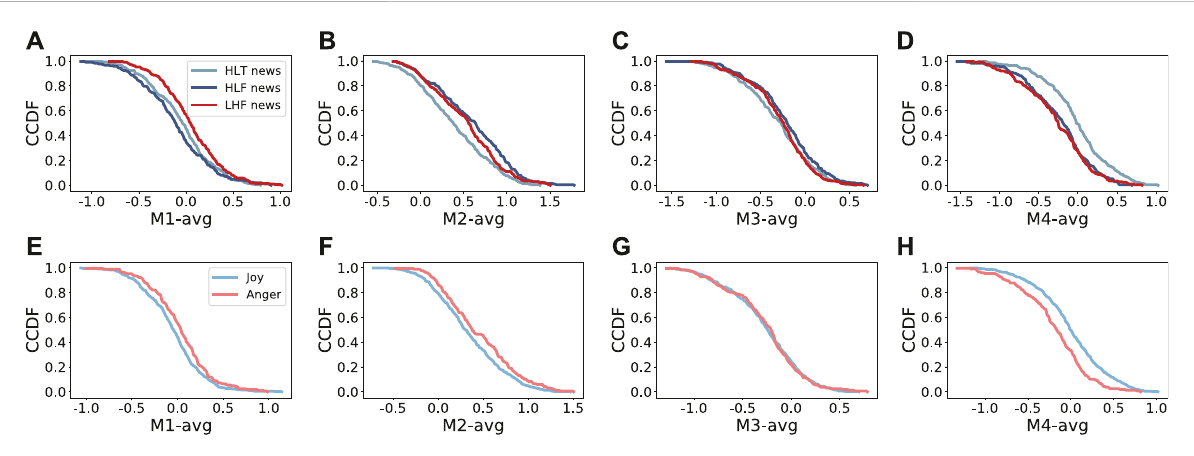
FIGURE 5 TheCCDFsofretweetingmotivations. (A,E) Anxietymanagement(M1-avg). (B,F) Informationsharing(M2-avg). (C,G) Relationshipmanagement (M3-avg). (D,H) Self-enhancement (M4-avg). (A – D) The CCDFs of four motivations inHLT news, HLF news, and LHF news. (E – H) The CCDFs offour motivations in anger-dominated news and joy-dominated news. The results of the K-S tests can be seen in Supplementary Material